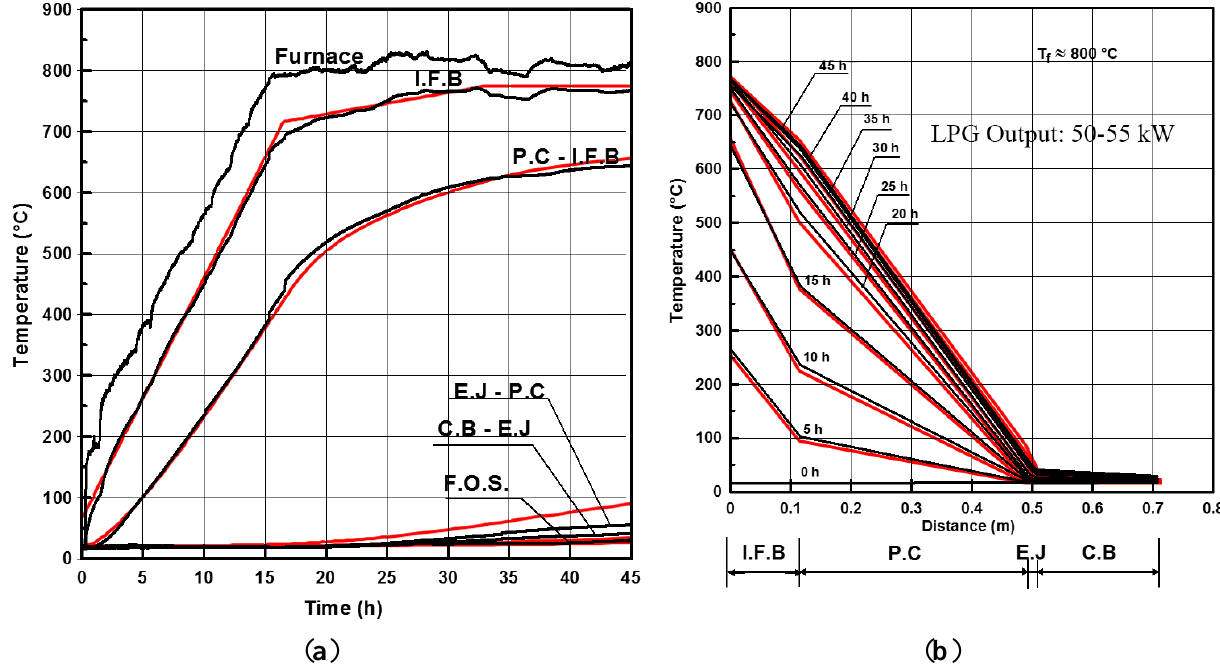
Figure 9. Experimental and simulation results of the TES bin for the half that was covered with IFB: ( a ) temperature over time and ( b ) transient to steady-state temperature distributions across the layers (black lines represent the experimental data, and red lines represent the simulation results).